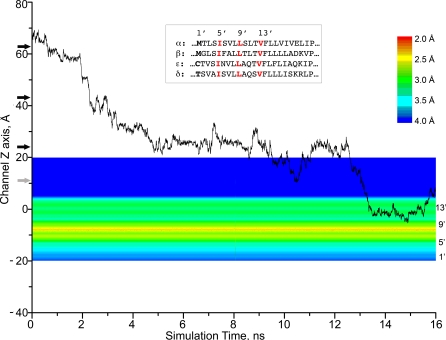
Position of a Cation along the Channel Axis from Simulation of the Restrained Structure at −100 mV Superimposed upon a Color-Encoded Plot of the Effective Pore Radius, as in Figures 2 and 4